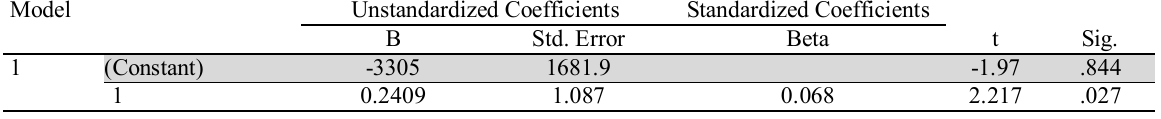
The results of regression analysis (Dependent Variable: